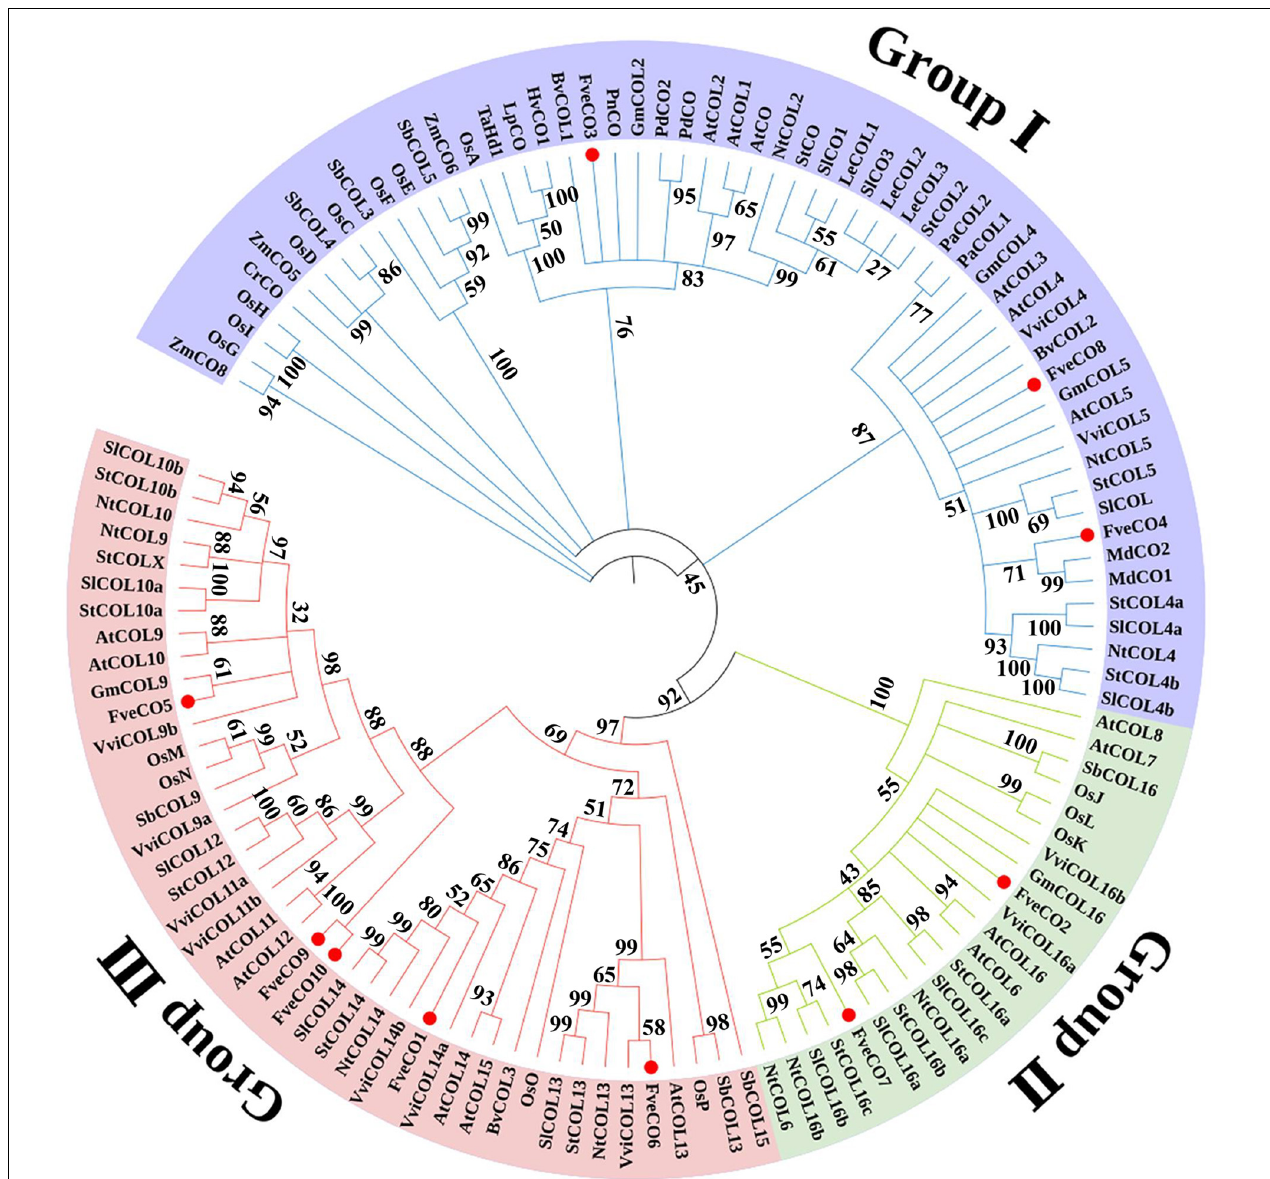
FIGURE 2 | Phylogenetic analysis of CONSTANS/CONSTANS-like (CO/COL) homologs in different species. The clades of groups I, II, and III are marked in green, blue, and pink, respectively. Fragaria vesca constans-like genes (FveCOs) are indicated by red points. At, Arabidopsis thaliana ; Ca, Capsicum annuum ; Gm,